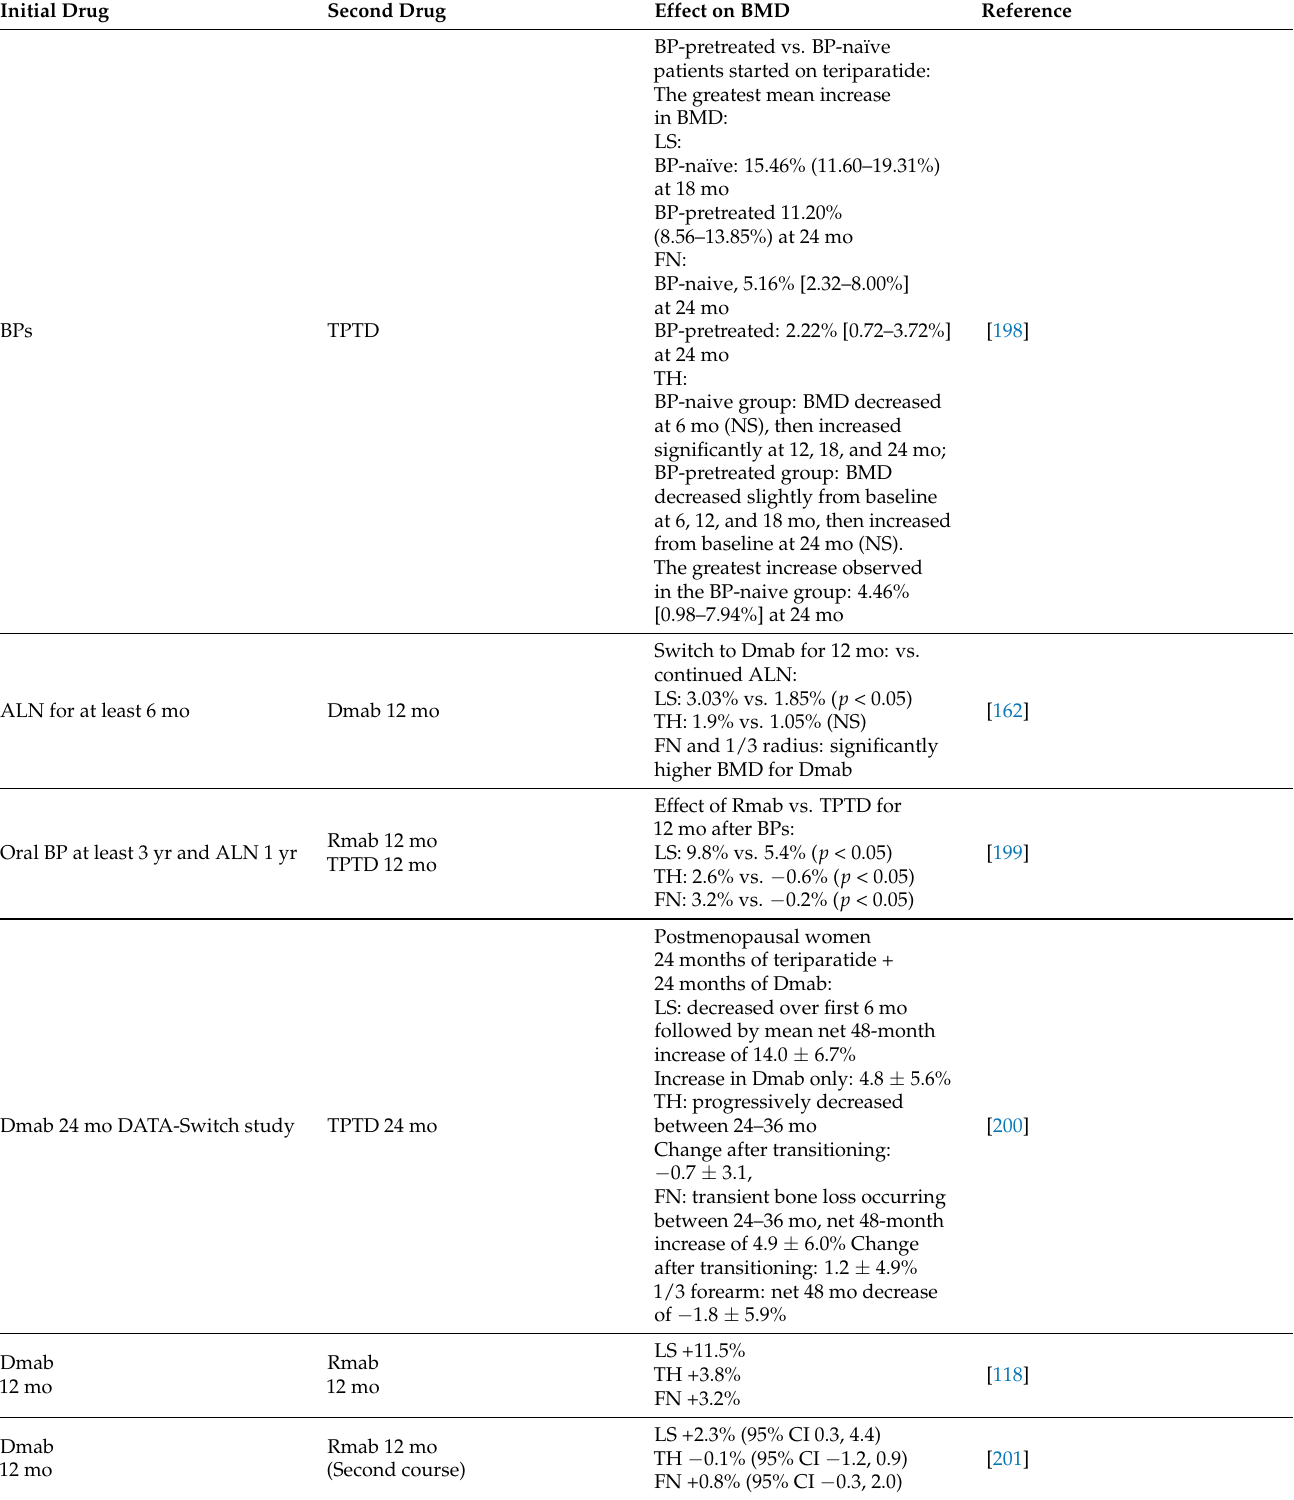
Table 6. Change in BMD based on sequence of antiosteoporosis medication